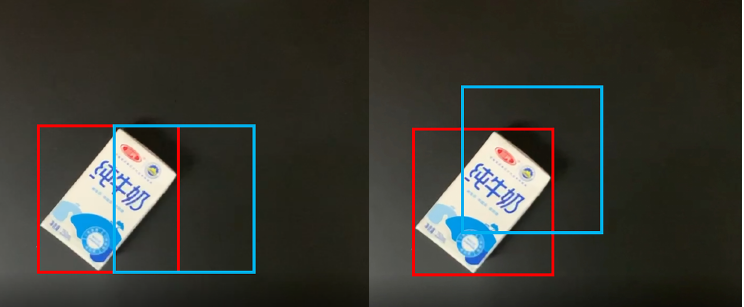
Figure 8. The case of equal IoU .